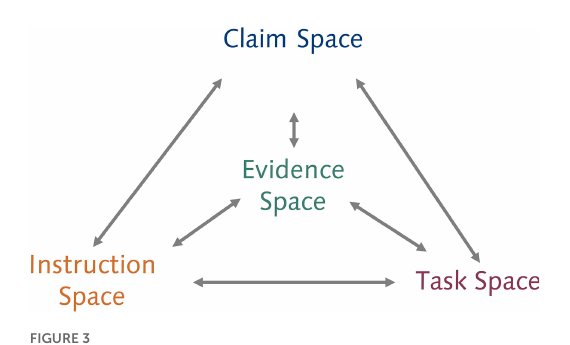
FIGURE3 Extension of evidence-centered design for Learning Progression Analytics